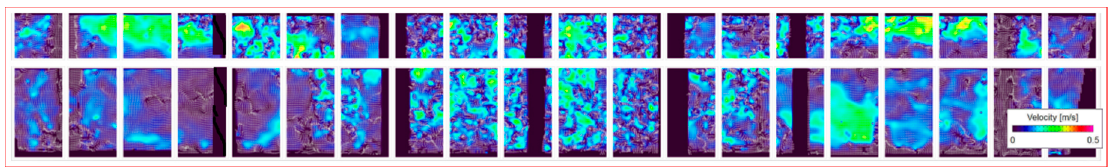
Figure 6. Flow measurement results obtained by scheme B.